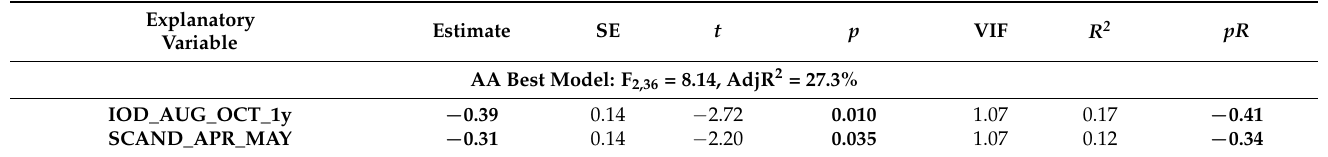
Table A16. Relationships between 15 climate variables and year and Annual Anomaly of the timing of spring migration for the Chiffchaff Phylloscopus collybita caught at Bukowo, Poland, in 1982–2021. Symbols as in Tables 1 and A12. p < 0.05 marked in bold face.